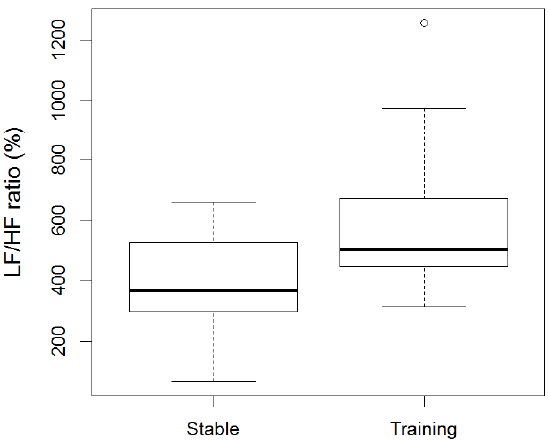
Figure 3. LF/HF ratio of horses before training (Stable) and during Monty Roberts’ public demonstrations (Training). The LF/HF ratio was significantly higher ( p = 0.01) in training when compared to stable. Analysed using generalized linear mixed models (GLMM) and Wilcoxon signed-rank test.